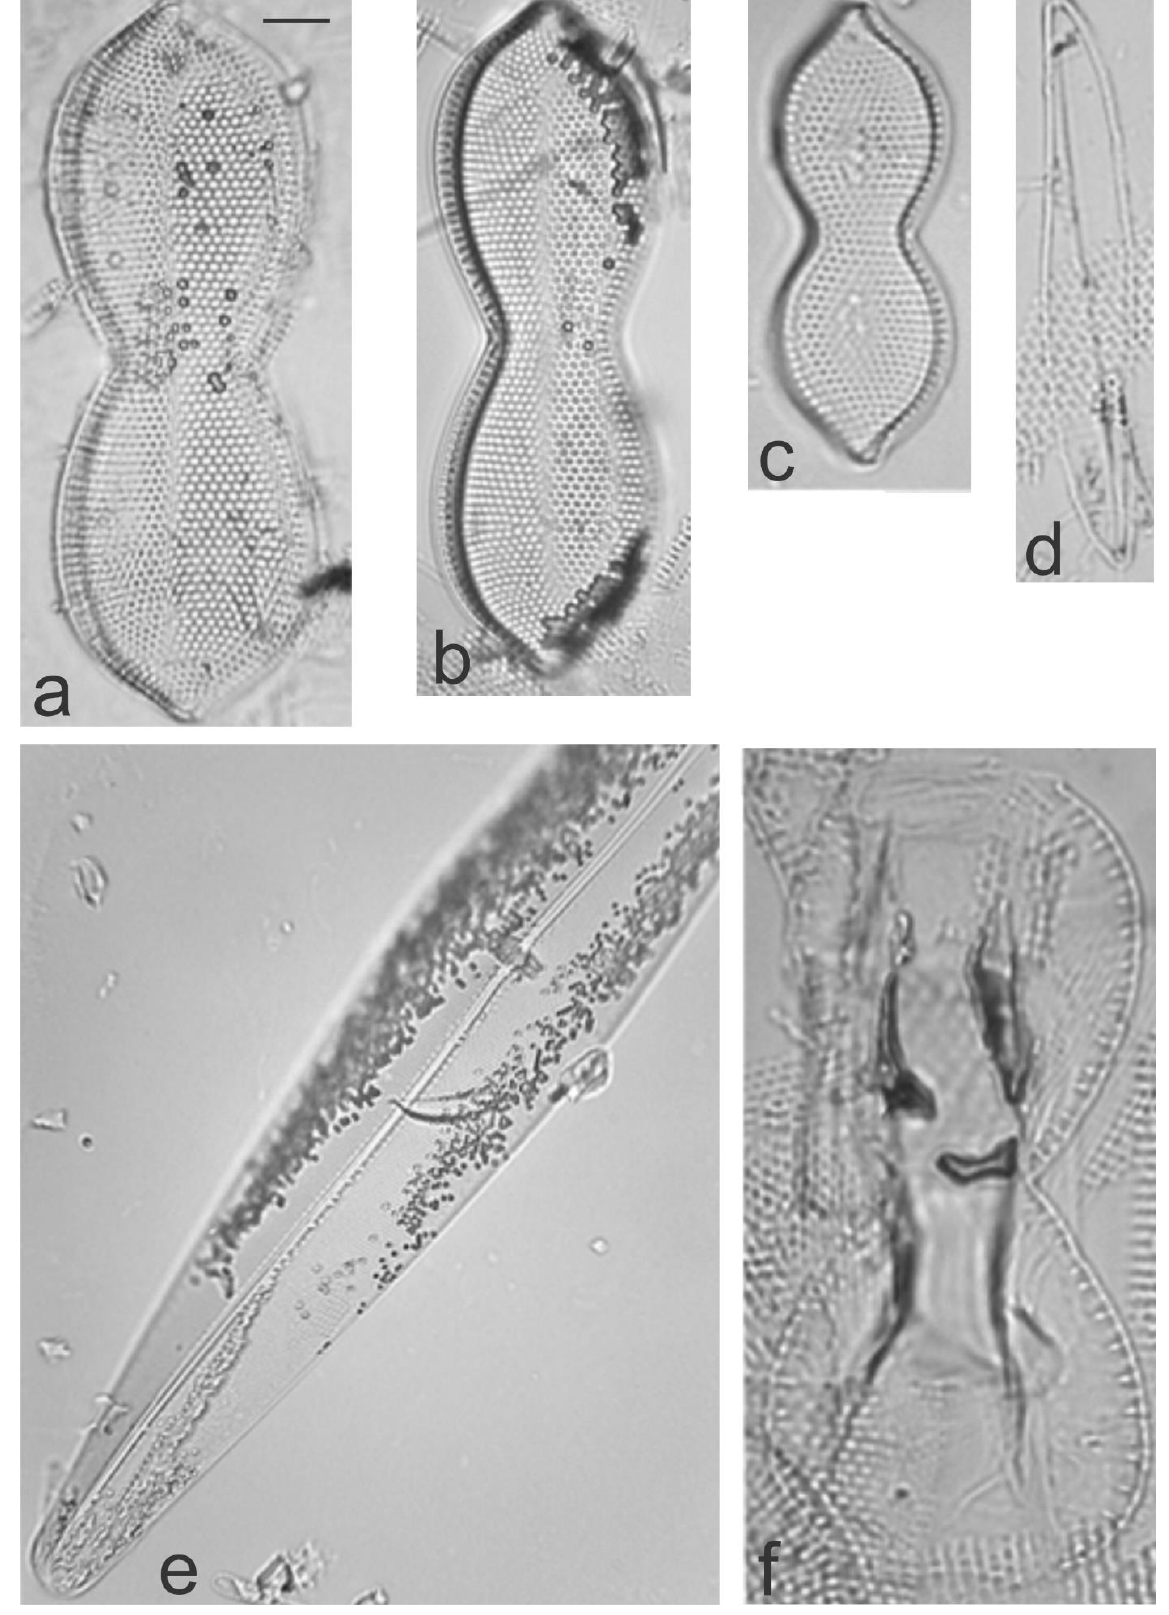
Figure 30. ( a , b ) Tryblionella didyma ; ( c ) Nitzschia bombiformis ; ( d ) Gyrosigma cf. parvulum ; ( e ) Pleurosigma barbadense ; ( f ) Entomoneis punctulata . Scale bars: ( e ) = 10 μm; all others = 5 μm.